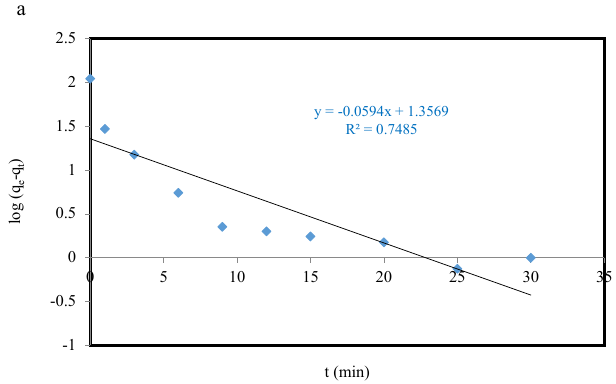
Fig. 10 (a) Linear pseudo-first-order kinetic plot, (b) linear pseudo-second-order kinetic plot and (c) intra-particle diffusion model